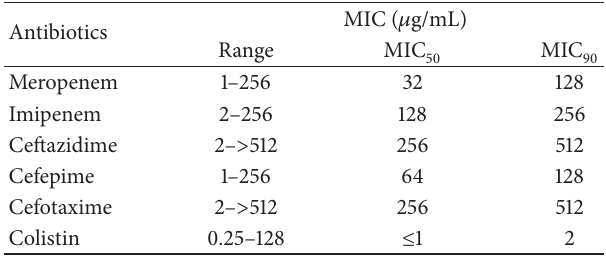
Table 2: Minimum inhibitory concentration of different antimicro- bial agents among 108 Acinetobacter baumannii isolates.